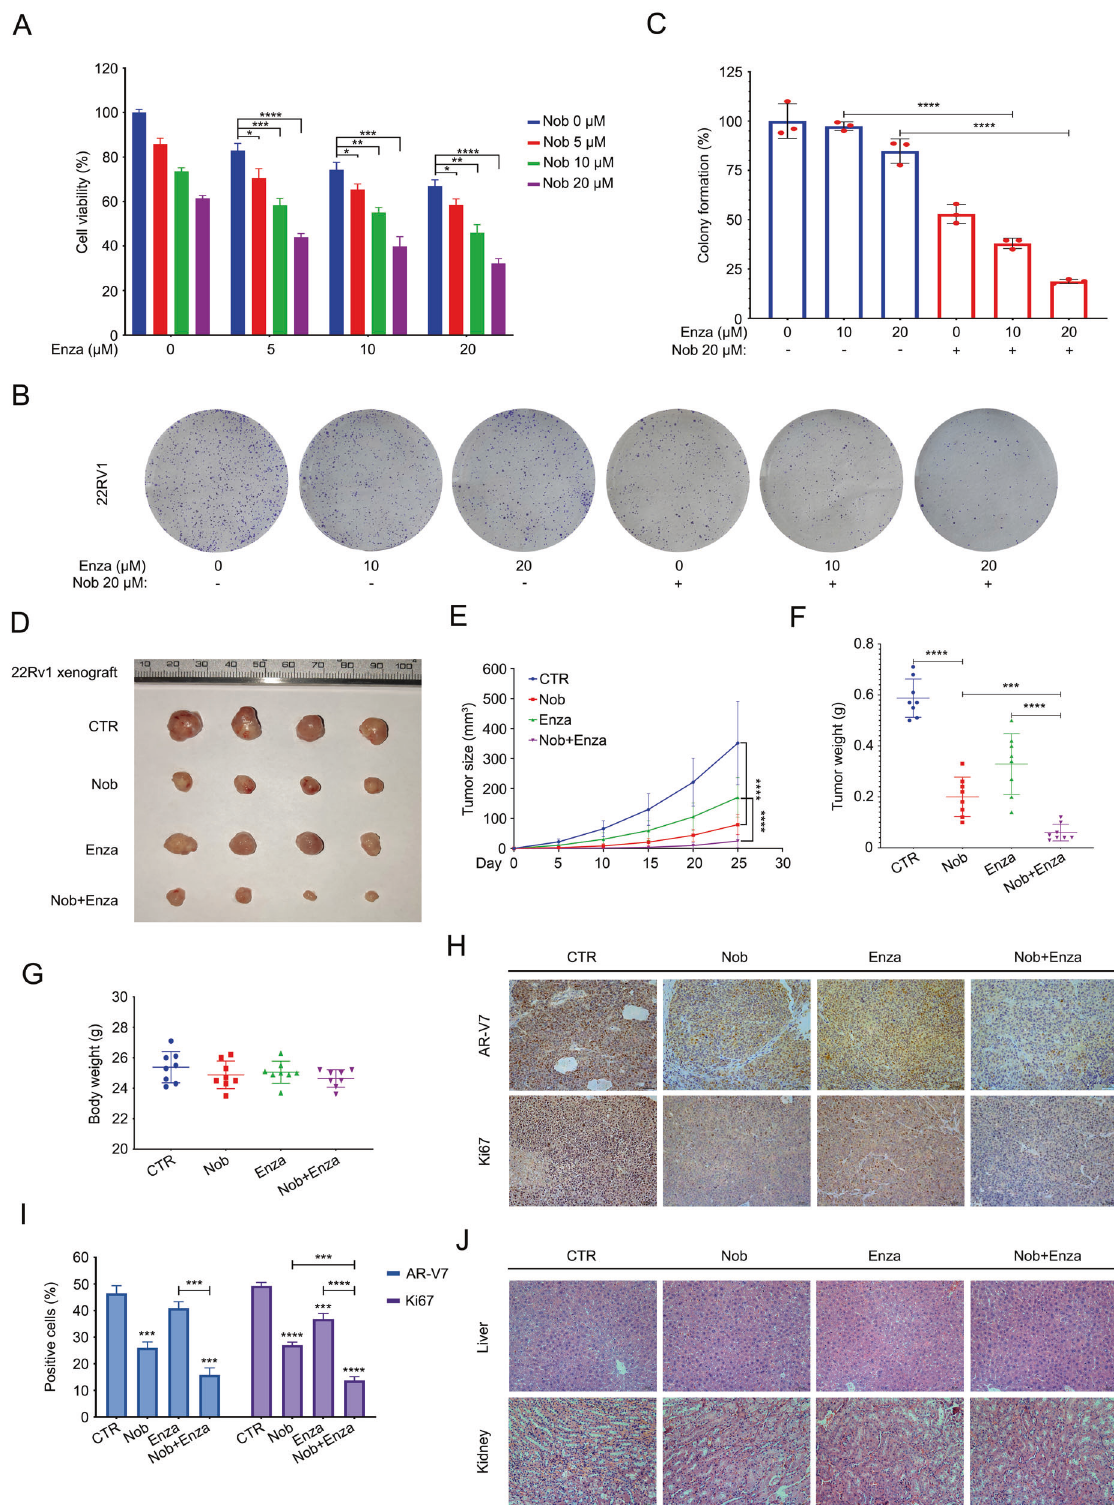
Fig. 6 Nobiletin enhanced the sensitivity of CRPC to enzalutamide. A CCK8 assay was performed in 22Rv1 cells treated with enzalutamide in the presence or absence nobiletin for 48 h. Mean ± SD ( n = 3). B Colony formation assay of 22Rv1 cells exposed to enzalutamide with or without nobiletin for 2 weeks. C Quantitative data of B are shown. Mean ± SD ( n = 3). D Xenograft images are shown. 22Rv1 xenografts treated with drug solvent, 40 mg/kg/2d (i.p.) of nobiletin, 25 mg/kg/2d (p.o.) of enzalutamide and combination of nobiletin and enzalutamide for 25 days. E Tumor sizes are shown. Mean ± SD ( n = 10). F Tumor weight are shown. Mean ± SD ( n = 10). G Body weight of nude mice are shown. Mean ± SD ( n = 10). H IHC assay of AR-V7 and Ki67. Representative images in per group are shown at 200*. I Quantitative data of H are shown. Mean ± SD ( n = 3). J H&E staining assay was performed in liver and kidney tissue of nude mice. Representative images in per group are shown at 200*. Cell Death and Disease (2021)